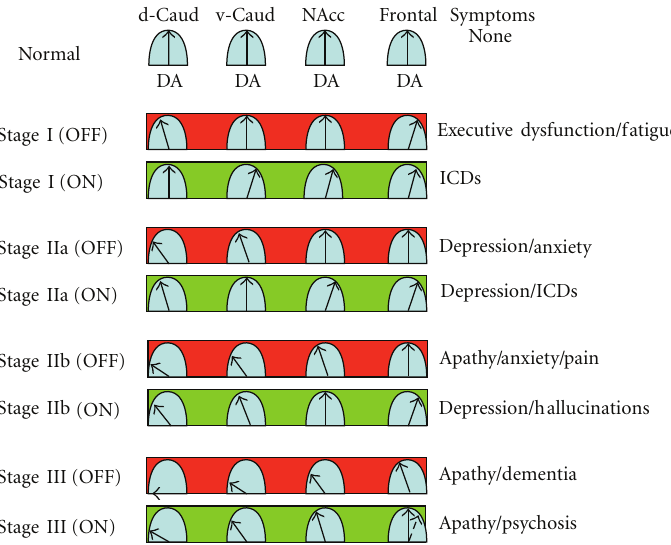
Figure 2: Parkinson’s disease related frontostriatal cognitive dysfunction (PDFCD) staging with region-specific dopamine (DA) levels. Dopamine-related frontostriatal functioning is assumed to follow an inverted U-shaped dose-response curve. Predicted stage-specific dopaminergic function, both o ff and on dopaminergic treatment, is shown for dorsal caudate (d-Caud), ventral caudate (v-Caud), nucleus accumbens (NAcc) and frontal cortex. In the ON state, the inverted U-shaped curves represent DA levels if the patient is on levodopa, and DA tone if the patient is on a dopamine agonist. The direct dopaminergic projection to the frontal cortex seems to be initially upregulated, but with limited capability to increase further the dopaminergic tone in response to dopaminergic treatment (see text for details). ICDs = impulse control